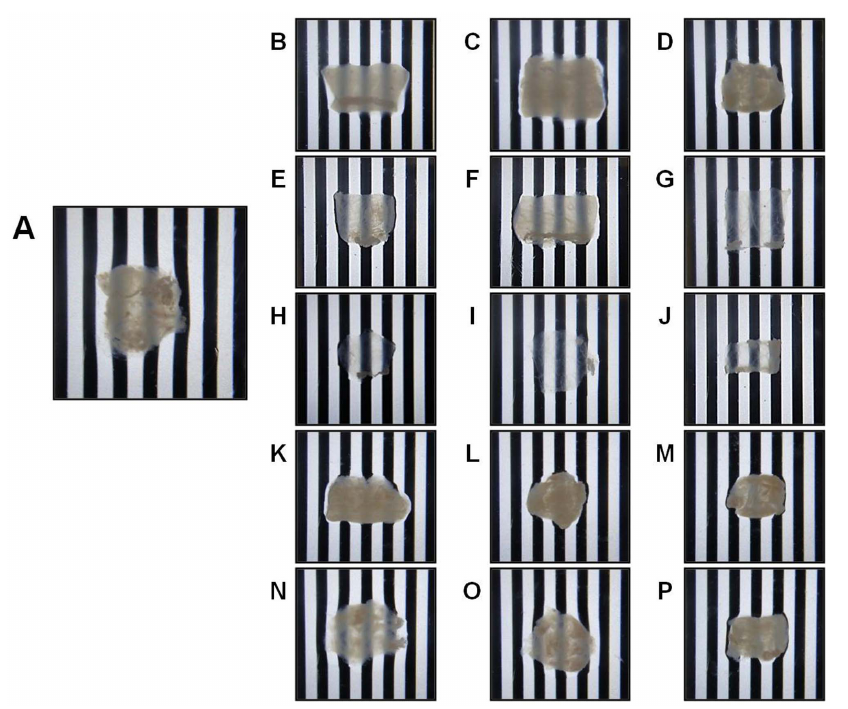
Figure 7. Photographic images of control and decellularized SI samples using a patterned surface to estimate transparency. Images correspond to control SI samples (A), and tissues decellularized with 1.5 M NaCl (B), 3 M NaCl (C), 5 M NaCl (D), 0.1% SDS (E), 0.3% SDS (F), 0.6% SDS (G), 0.1% triton X-100 (H), 0.3% triton X-100 (I), 0.6% triton X-100 (J), 10 min SC (K), 20 min SC (L), 30 min SC (M), 10 min UV (N), 20 min UV (O) and 30 min UV (P).